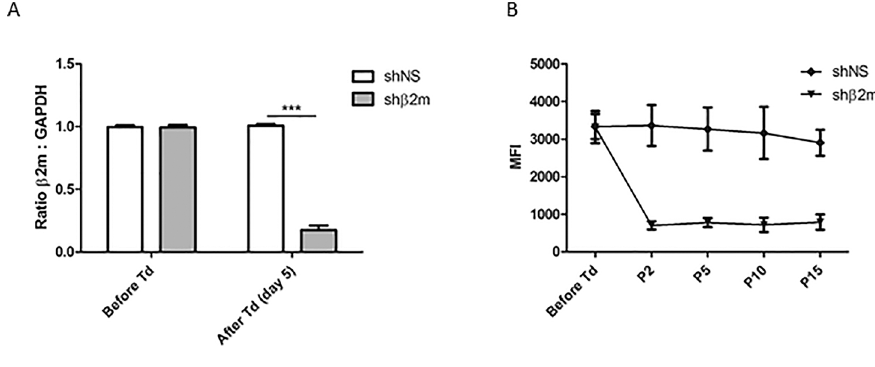
Figure 1. Generation of a HLA-universal iPSC line. iPSCs cultured in monolayer on Laminin-521-coated plates were transduced with a lentiviral vector (pLVTHm) encod- ing the sequences for a nonspecific shRNA (shNS) or a shRNA targeting β 2m transcripts (sh β 2m). (A) Levels of β 2m transcripts measured by real time PCR before and 5 d after cell transduction (Td). GAPDH was used as housekeeping gene to normalize cDNA levels. (B) Expression levels of HLA class I measured by flow cytometric analysis prior transduction and at passages (P) 2, 5, 10 and 15. Graphs show mean ± standard deviation (SD) ( n = 4, *** p ≤ 0.001).